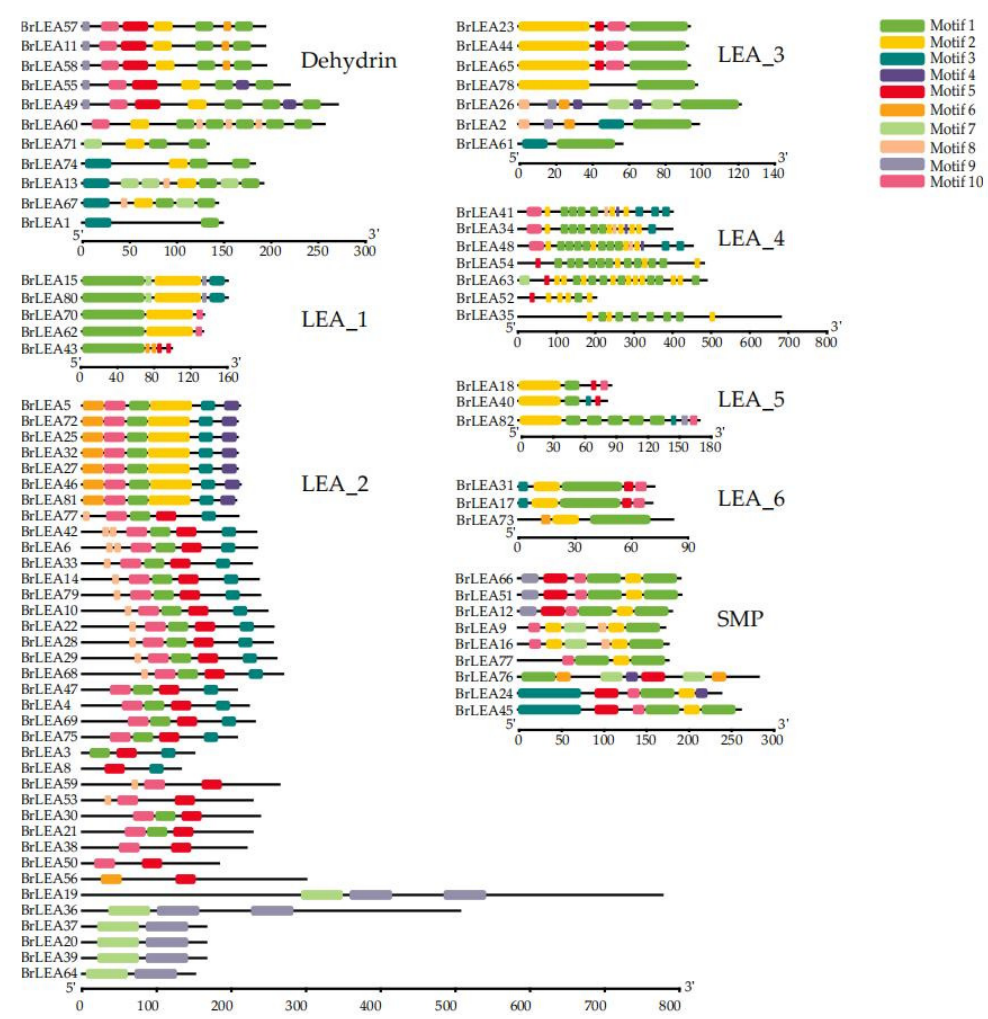
Figure 2. Analysis of the conserved motifs of the BrLEA gene